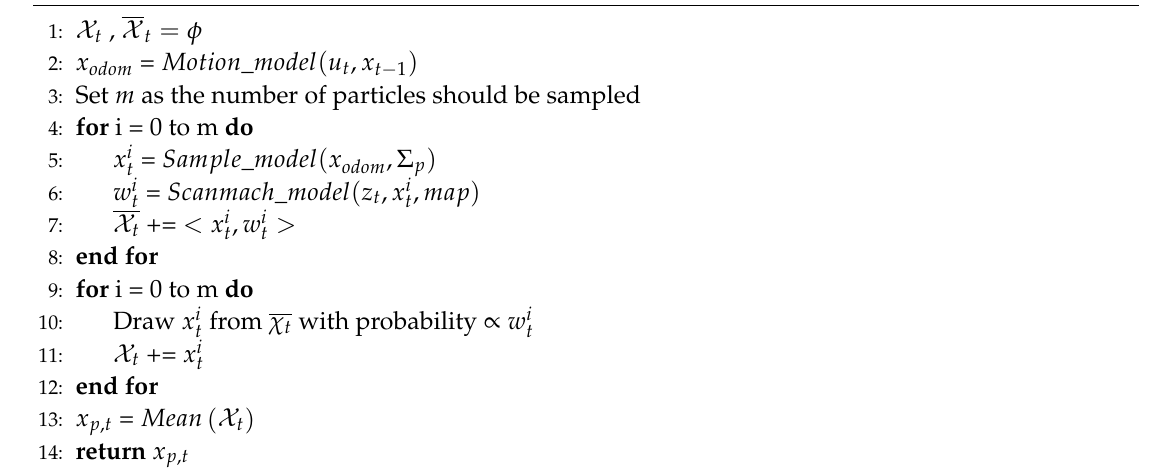
Algorithm 2 Improved PF-based Localization ( x t − 1 , u t , z t , Σ p